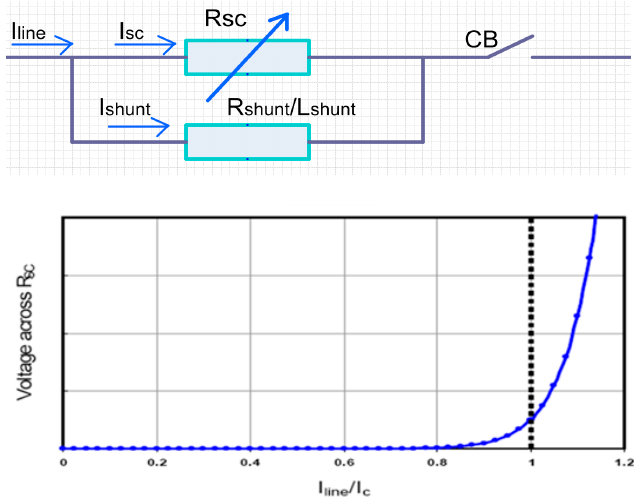
Figure 7. Electrical characteristics of superconductor of resistance.